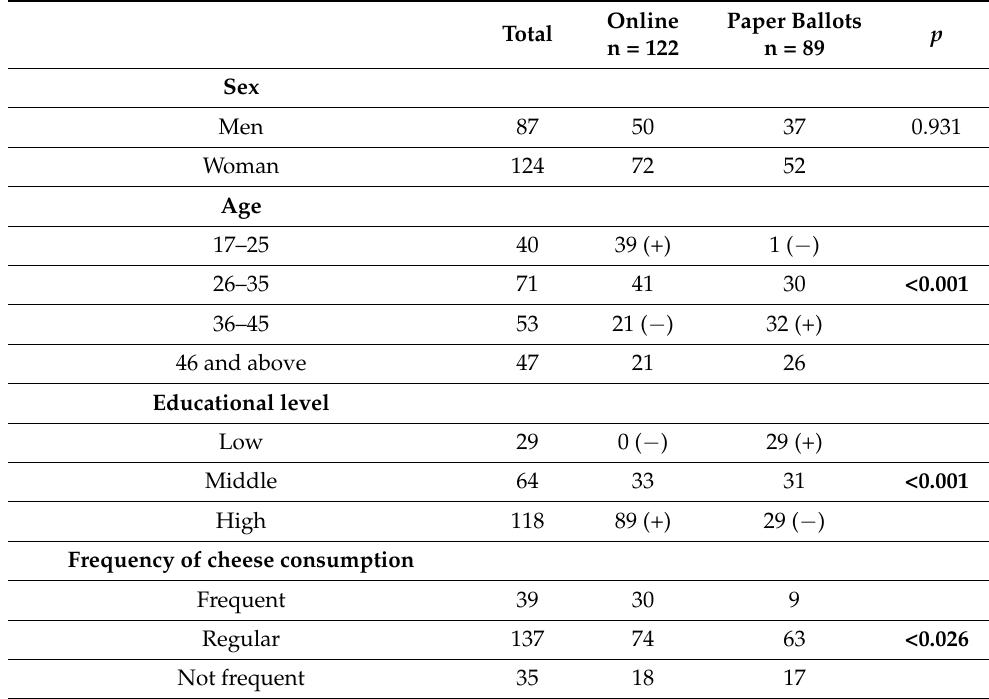
Table 1. Sociodemographic characteristics of the samples studied from the two surveys: paper ballots and online